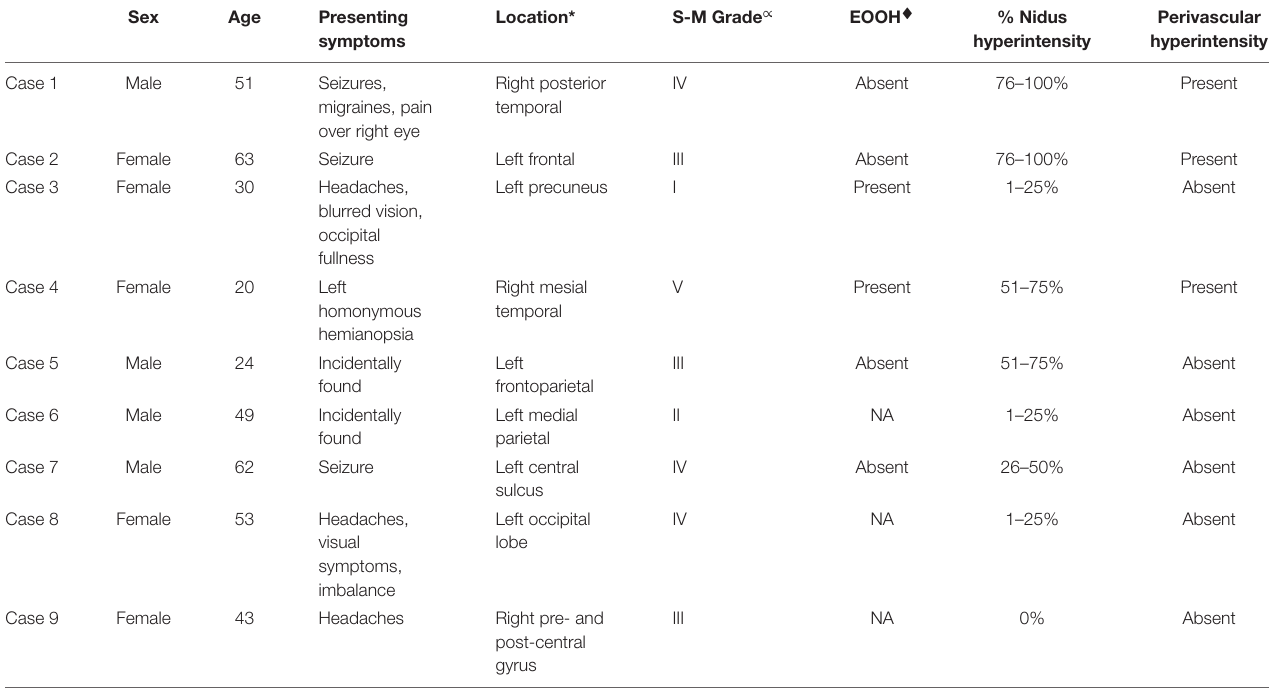
TABLE 1 | Arteriovenous malformation (AVM) case demographics and